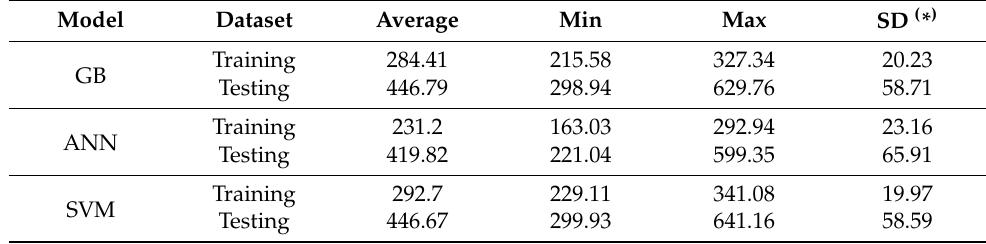
Table 5. Summary of the 300 samplings using RMSE criteria.